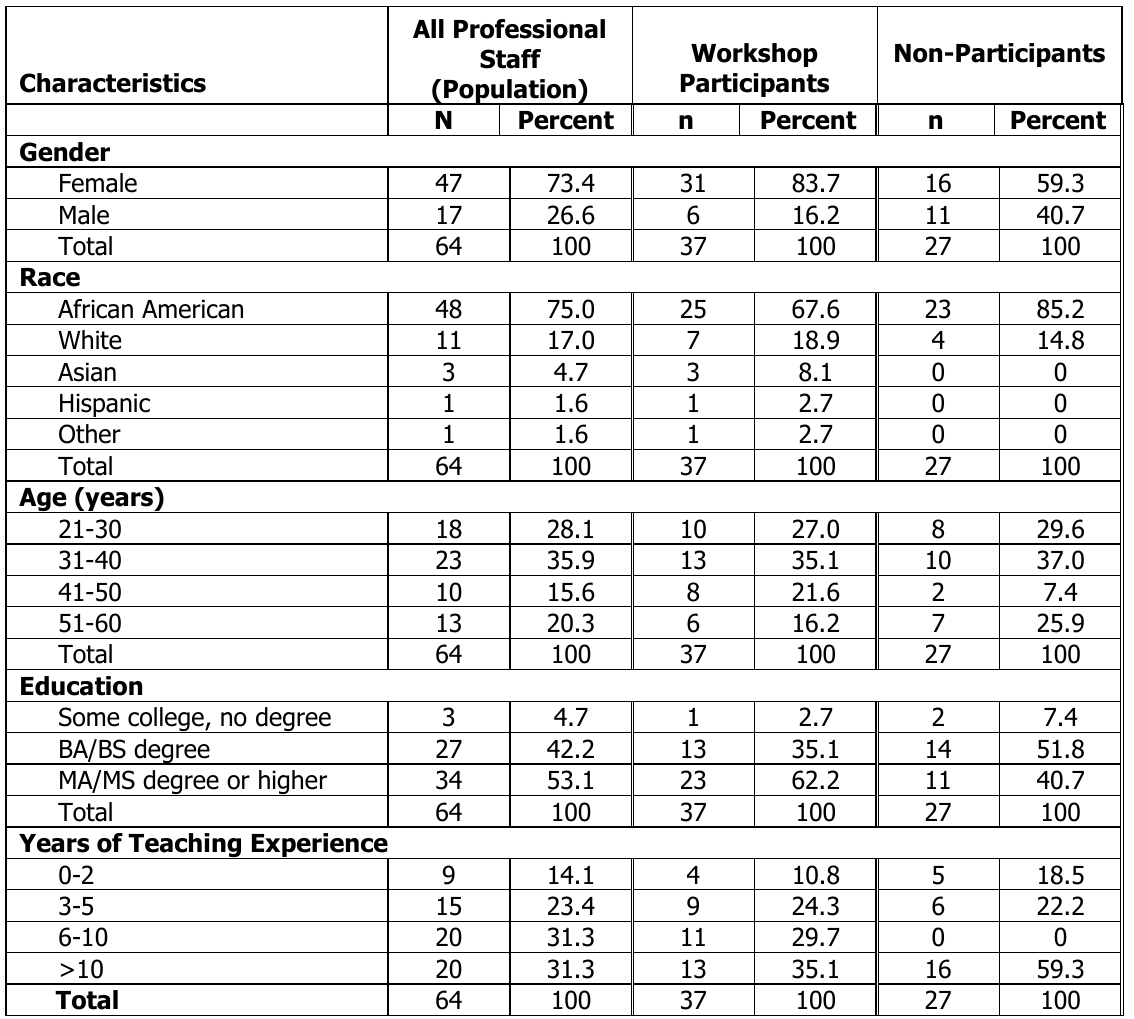
Comparison of Selected Demographic Characteristics for Middle School Professional Staff as a Whole vs. Workshop Participants vs. Non Participants